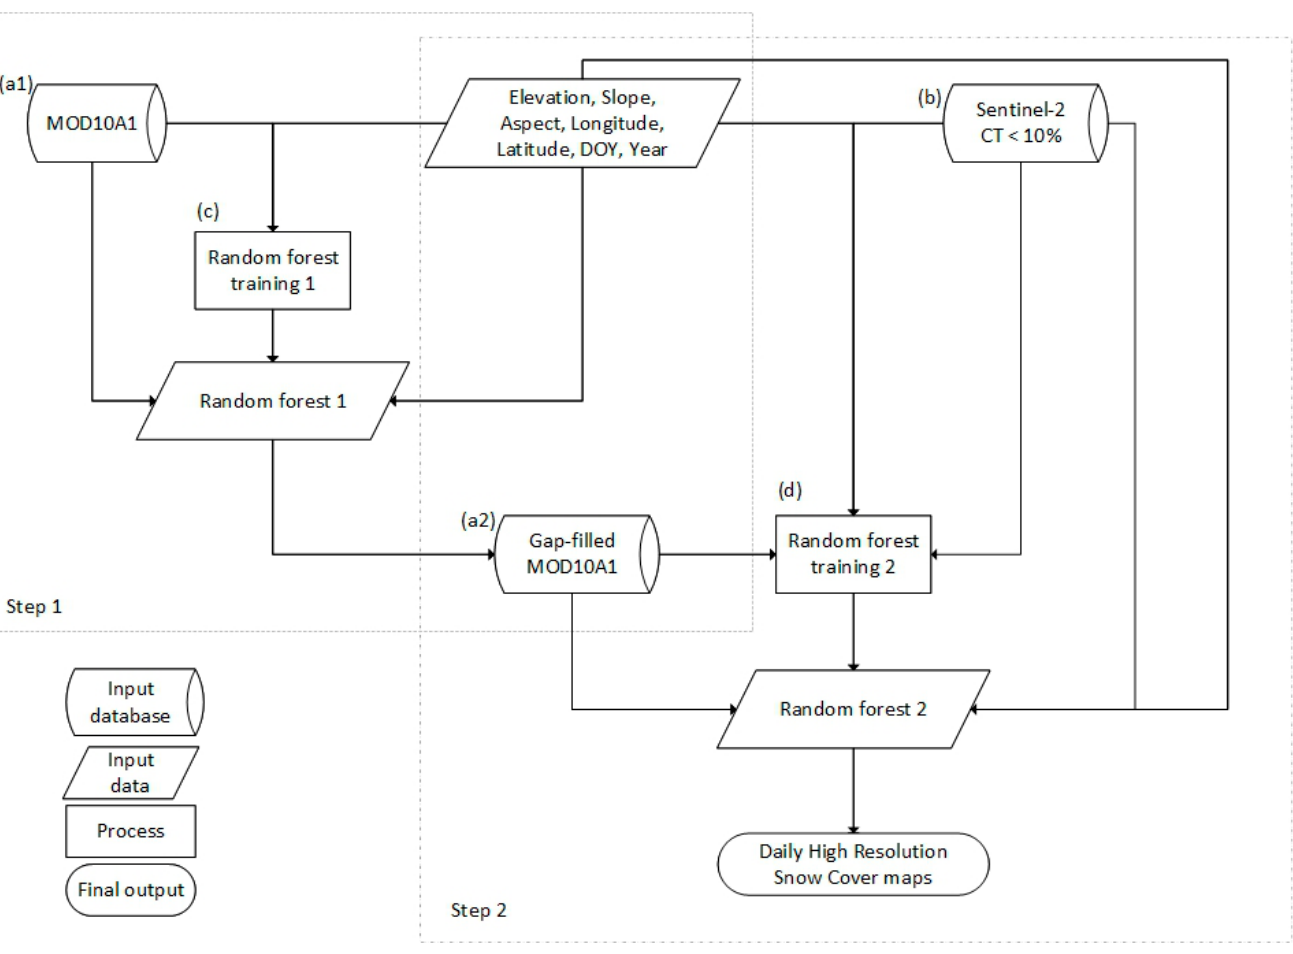
Figure 2 . Algorithm workflow chart. ( a1 ) MODIS dataset: in Approaches 1 and 2 is selected the Fractional Snow Cover (FSC), in Approach 3 is selected the Normalized Difference Snow Index (NDSI). ( a2 ) MODIS dataset of step 1 after gap-filling. ( b ) Sentinel-2 dataset: in Approach 1 is selected the Snow Cover Extent (SCE) product derived from Sentinel-2 imagery. In Approaches 2 and 3 is selected the NDSI derived from the same Sentinel-2 imagery. ( c ) Random forest 1: in all the three approaches is a regression random forest. ( d ) Random forest 2: in Approach 1 is a classification random forest, whose output is directly the binary snow cover, in Approaches 2 and 3 is a regression random forest, which gives as intermediate output the NDSI map, subsequently converted in the final binary snow cover output.